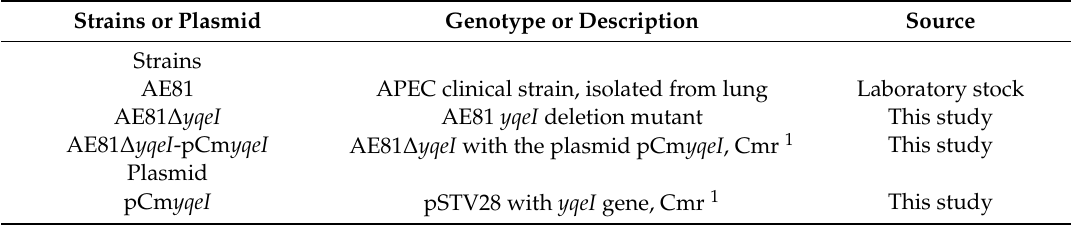
Table 1. Strains and plasmid used in this study.